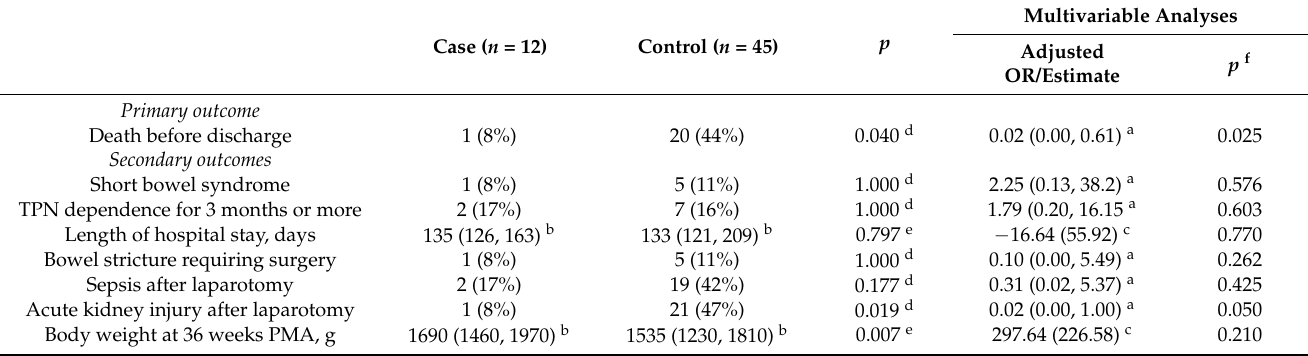
Table 3. Primary and secondary